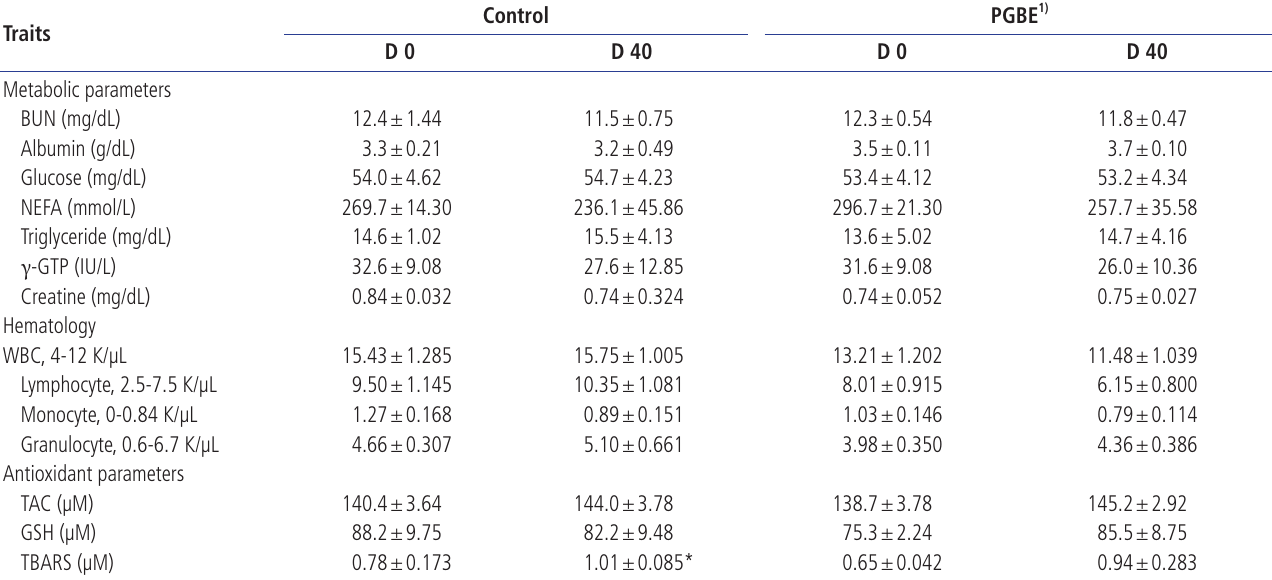
Table 4. Effects of PGBE complex on blood traits in dairy cows